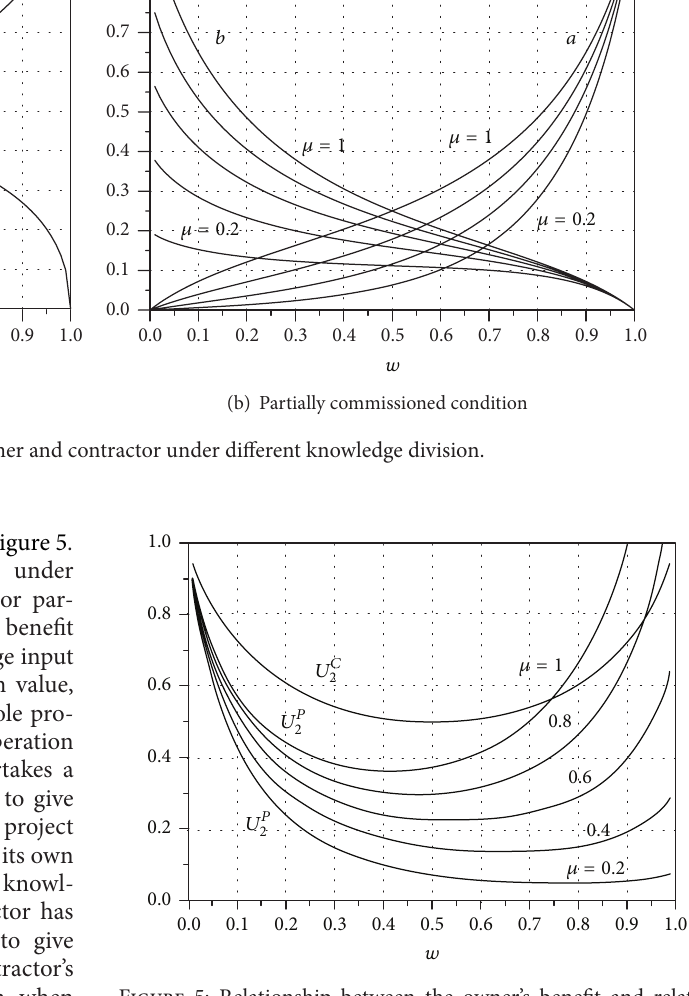
Figure 5: Relationship between the owner’s benefit and relative importance under different knowledge